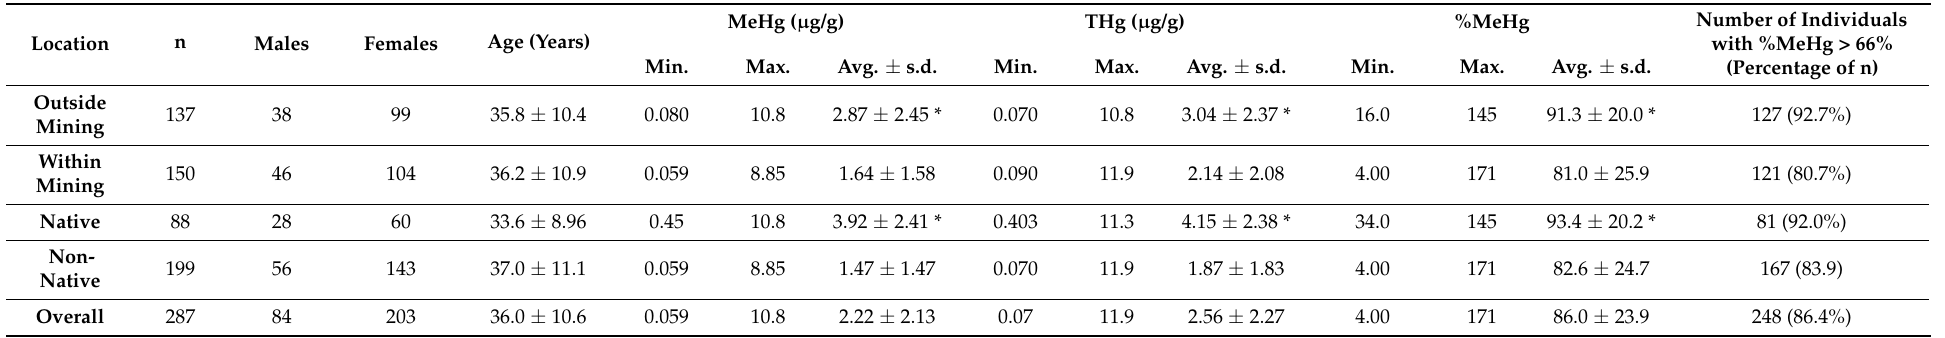
Table 1. Descriptive statistics for hair MeHg, hair THg, and %MeHg for participants within versus outside of mining as well as in native versus non-native communities along the MDD and Puquiri rivers. Communities outside of mining: Salvacion, Shintuya *, Shipitiari *, Diamante *, Isla de los Valles *, Boca Manu, Puerto Azul *, San Lorenzo *, Quincemil. Communities within mining: Masenawa *, Boca Isiriwe *, Boca Colorado, Puerto Luz *, Puquiri, Choque, Huepethue, Querada Nueva, Caychihue, Punquiri. *Native Community. MeHg ( µ g/g) THg ( µ g/g) %MeHg Number of Individuals Location n Males Females Age (Years)